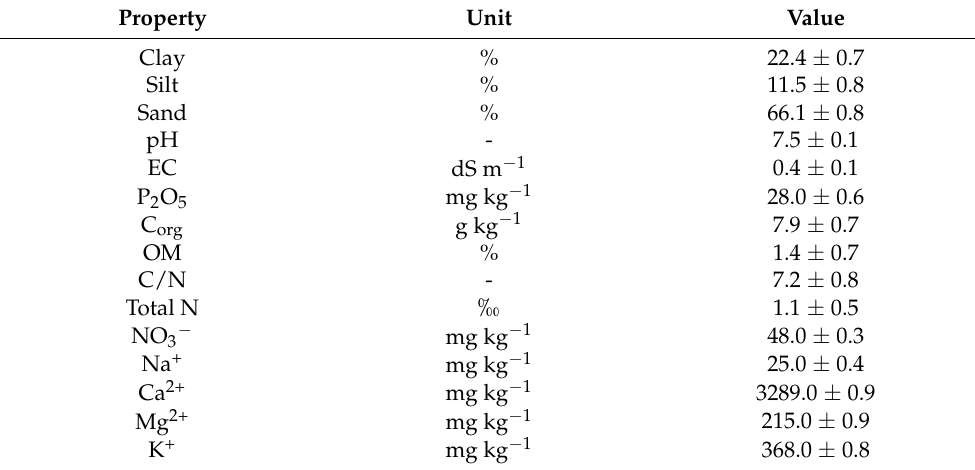
Table 1. Main physico-chemical properties of the soil utilized in the experiment.